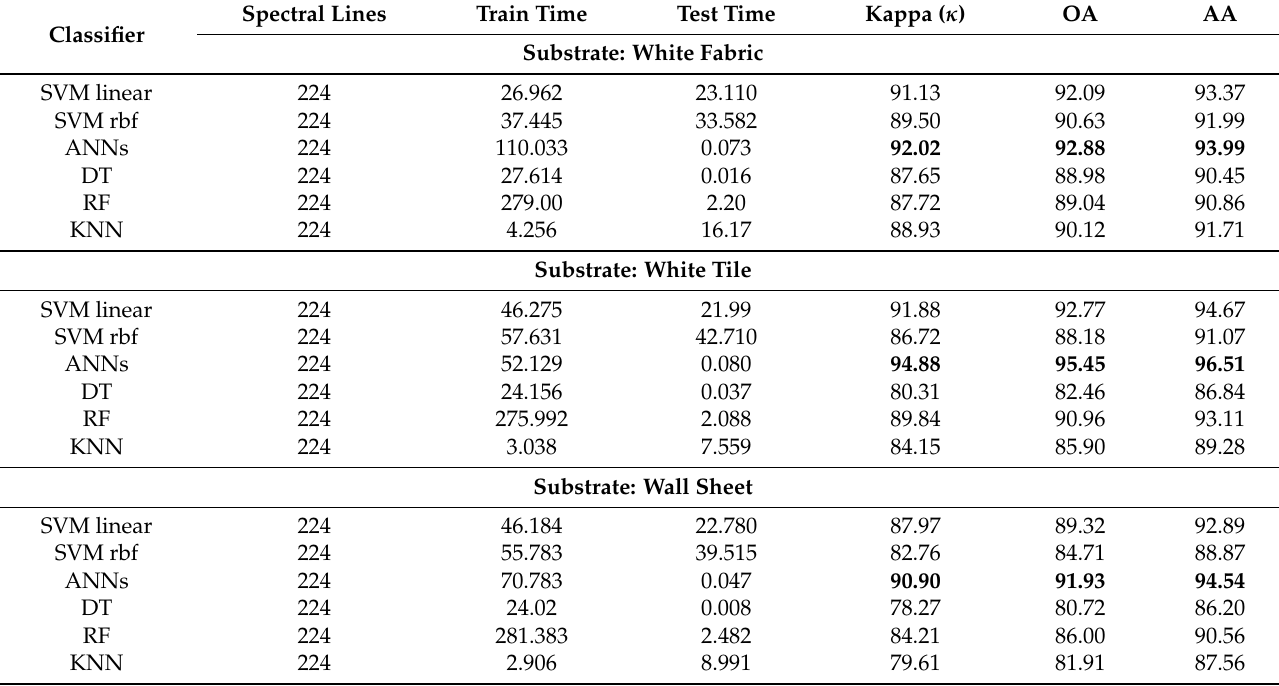
Table 6. Day-1: Blood vs. blood samples experimental results with full wavelengths. The best accuracies are